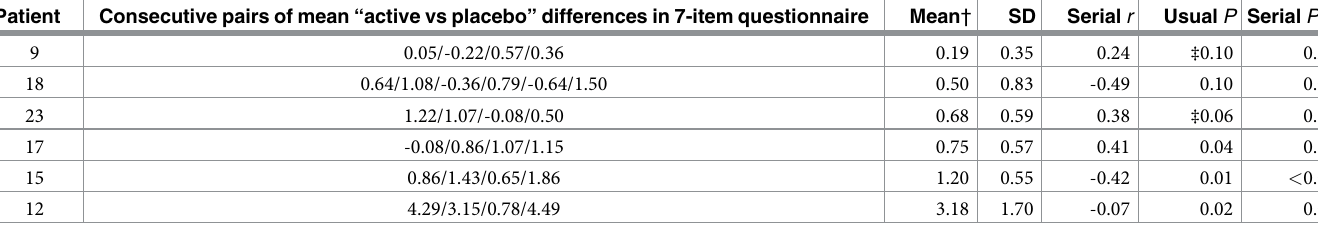
Table 4. N- of-1 randomized control trial data from